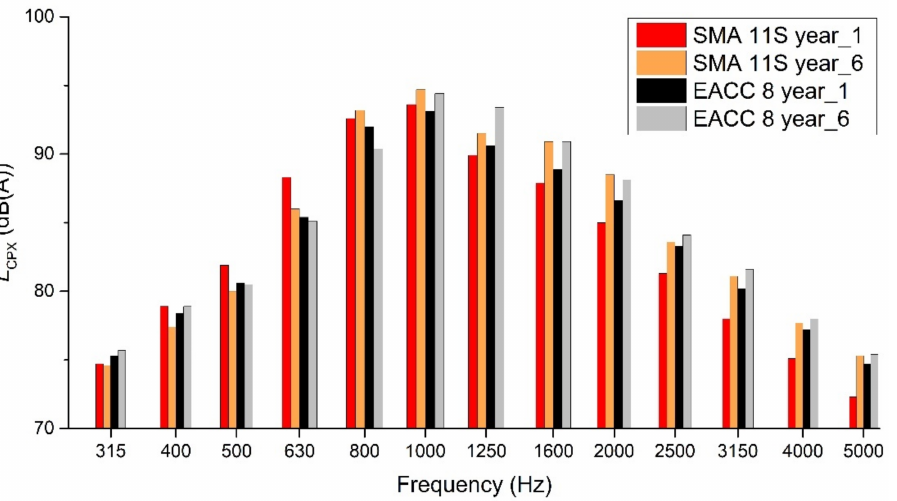
Figure 11. Frequency spectra of tyre/road noise for SMA 11S and EACC 8 in years 1 and 6 after